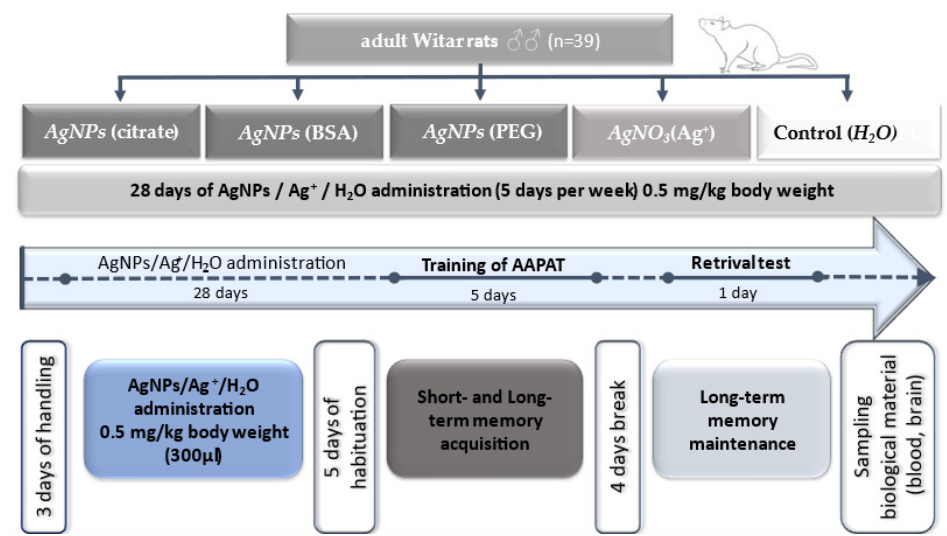
Figure 6. Experimental design and procedure scheme. Handling of rats was started 3 days before the administration of AgNPs/Ag + /H 2 O. The rats were habituated for behavioral training during the last 5 days of AgNPs